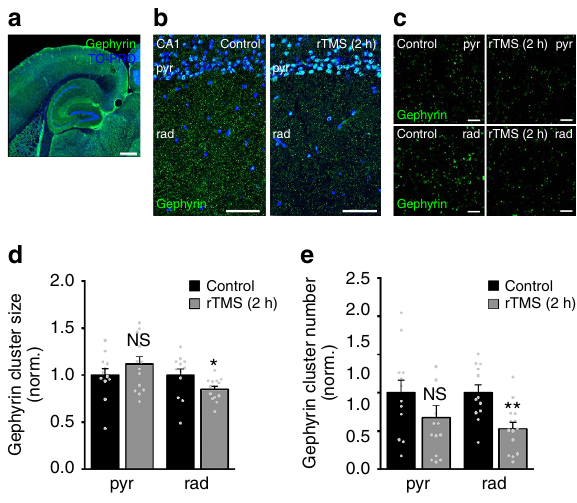
Figure 8 | TMS induces changes in gephyrin clusters in vivo . ( a – c ) Examples of horizontal brain slices containing the hippocampus stained for gephyrin from non-stimulated anaesthetized 3-month-old male mice and 2h after 10-Hz rTMS. Experimental conditions were adapted to the in vitro experiments. An increase in gephyrin immunostaining co-localizing with TO-PRO nuclear stain (blue) was noted. Scale bar in a , 300 m m, in b , 50 m m, in c , 4 m m. ( d , e ) A significant reduction in gephyrin cluster sizes and numbers was observed in rad but not in pyr 2h after stimulation (control, n ¼ 12 hippocampi from six animals; rTMS, n ¼ 14 hippocampi from seven animals; Mann–Whitney test). Individual data points are indicated by grey dots. Values represent mean ±